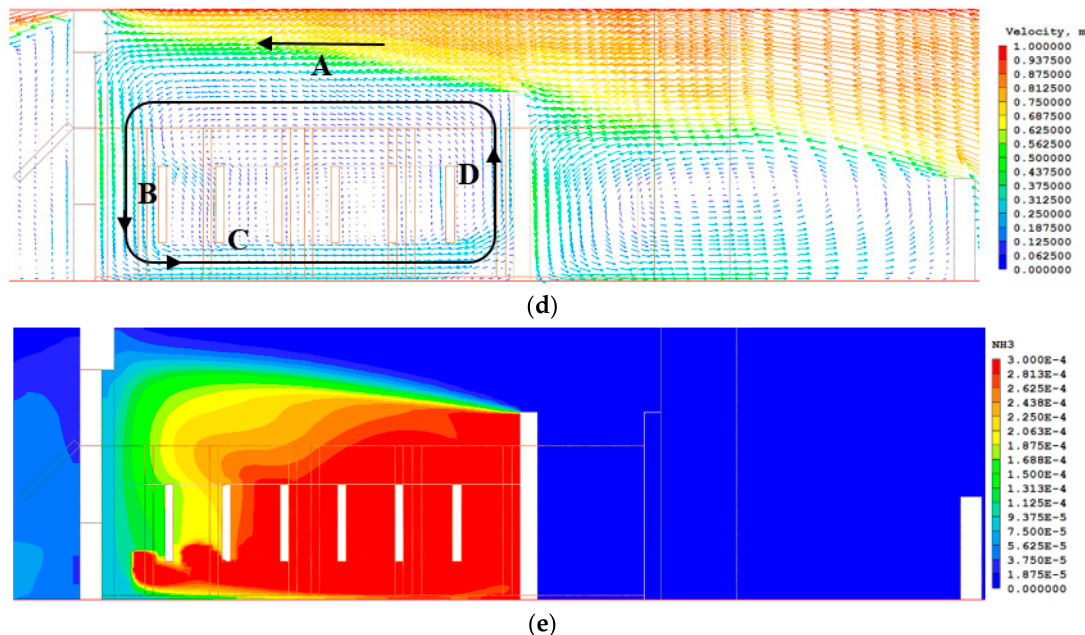
Figure 7. Indoor flow field and NH 3 concentration (PPMV) distribution for south wind (window configuration: W2; the opening angle θ is 45 ◦ ; the outdoor wind speed is 1 m / s). ( a ) Flow field